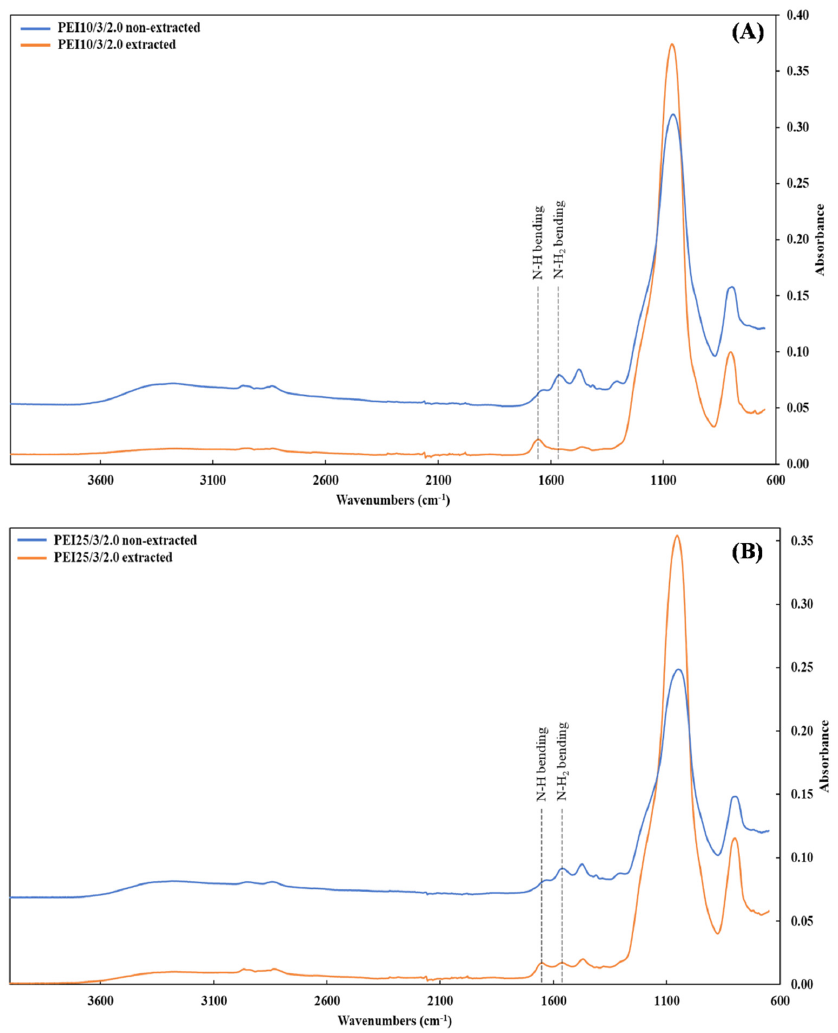
Figure 3. FTIR spectra of the samples ( A ) PEI10/3/2.0 and ( B ) PEI25/3/2.0 before (blue line) and after (orange line) extraction.